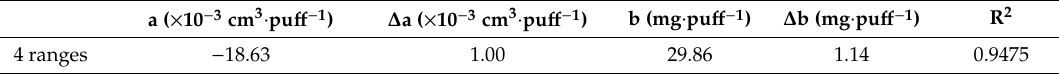
Table 7. MVE—Values of the coe ffi cients (a) and (b) and their standard deviations ( ∆ a) and ( ∆ b) in Equation (2) of the {PG-VG}, {PG-VG-EtOH}, {PG-VG-H 2 O}, and {PG-VG-EtOH-H 2 O} ranges (R 2 = coefficient of determination).